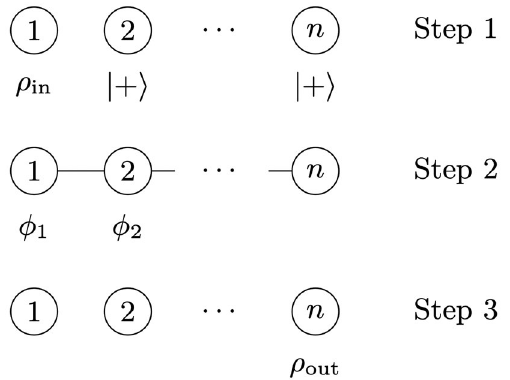
Figure 1. Summary of measurement-based processing with a n -qubit linear cluster state. Step 1 shows the initialisation of the qubits. Step 2 shows the entangled cluster state (after application of controlled phase gates between adjacent qubits) as well as the measurements performed on each qubit. Step 3 shows the state resulting from these